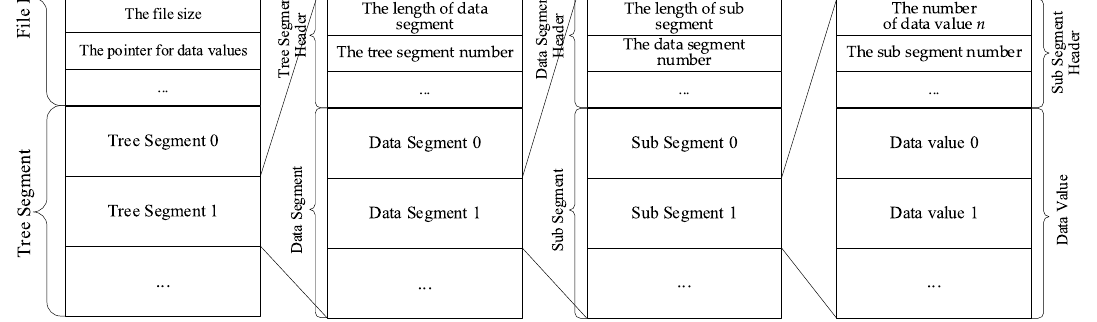
Figure 5. The binary file structure of TSMLD.